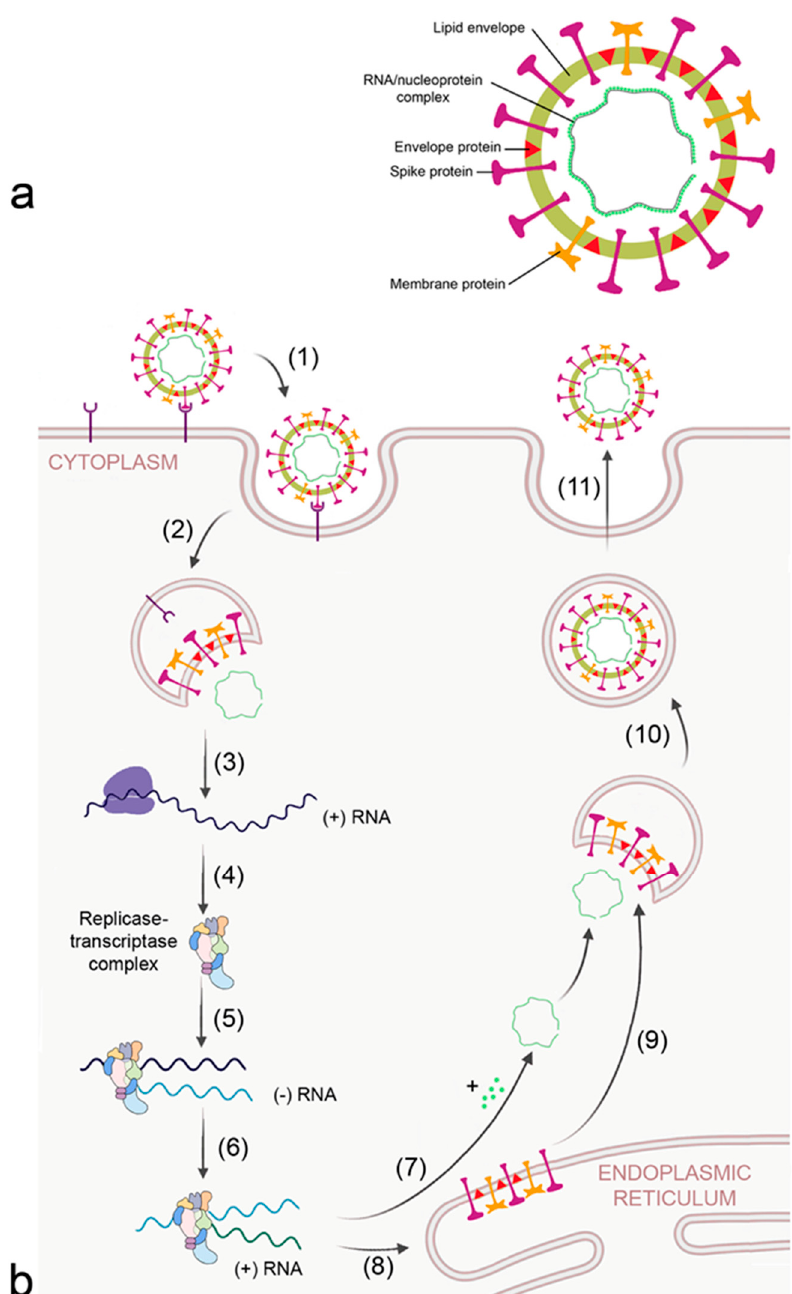
protein complex; (12) transport of the nucleoprotein complex out of the nucleus by viral nuclear export protein; (13) integration of HA, NA, and M2 into the budding plasma membrane, and (14) release of the virion by NA action.